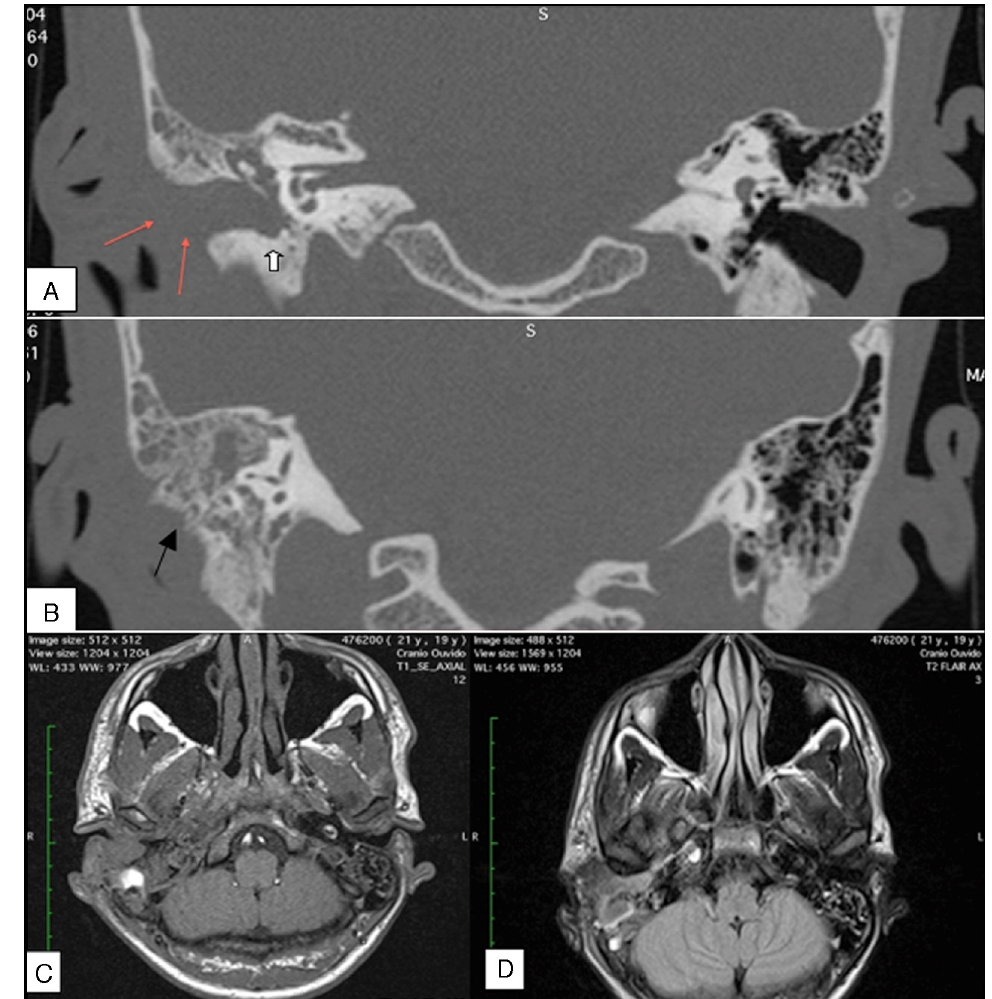
Figure 1 High-resolution coronal computed tomography images of the mastoids (A and B). (A) Erosion of the posterior wall of the external auditory canal (EAC; white arrow) and thickening and enhancement of the soft tissue in the region of the EAC (red arrow). (B) Erosion of the mastoid cortex (black arrow) and destruction of the bony septae. Magnetic resonance imaging of the mastoids (C and D). (C) Axial, T1-weighted image demonstrating infiltration of the soft tissues around the EAC, subcutaneous tissue, and parotid gland. (D) Axial, T2-Flair image showing the tympanic and mastoid cavity, with tissue contrast uptake spreading anteroin-